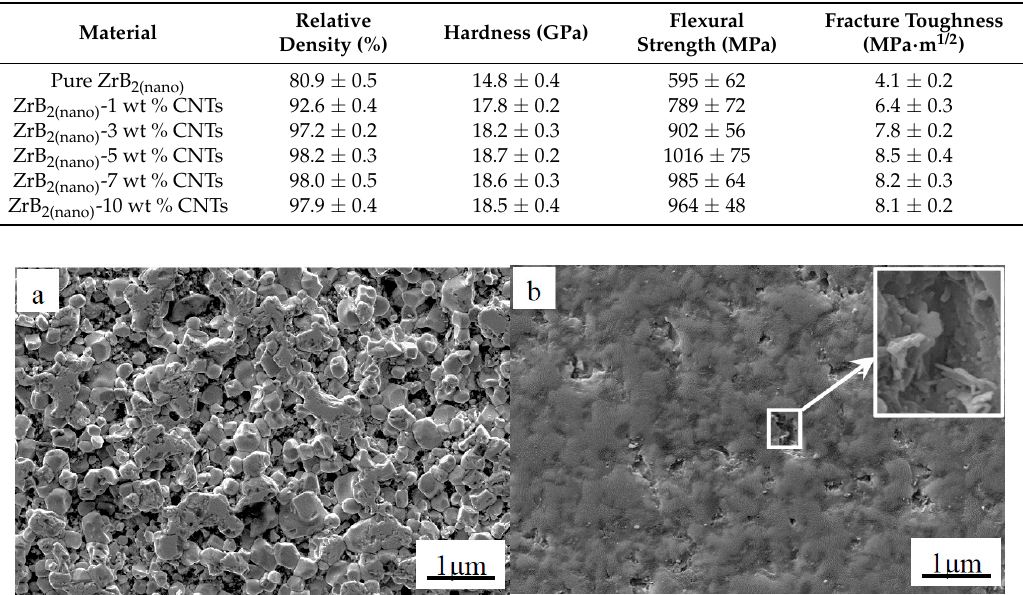
Table 1. Table 1. Density and mechanical properties of the ZrB 2(nano) - x wt % carbon nanotubes (CNTs) composites.